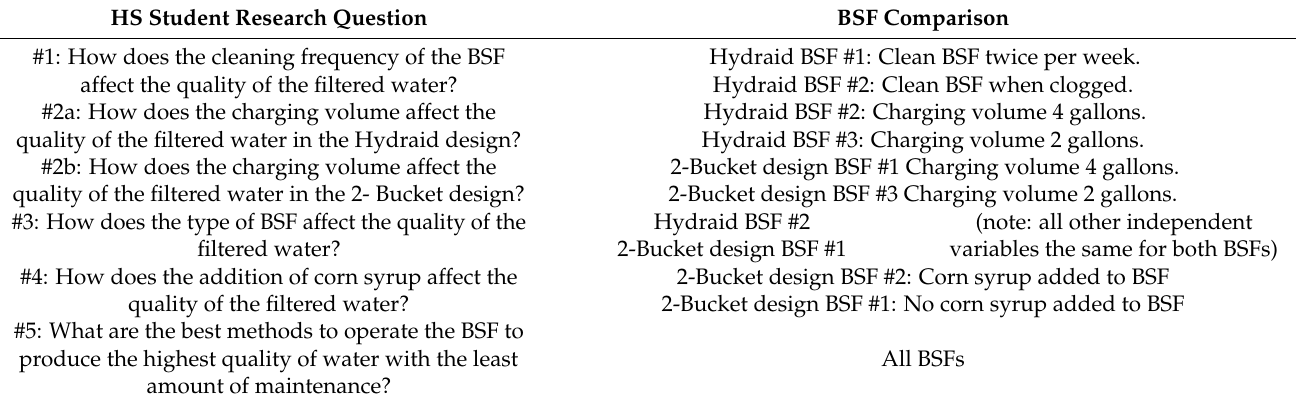
Table 2. Experimental design for to ensure that two BSFs only differed by the one independent variable of the research